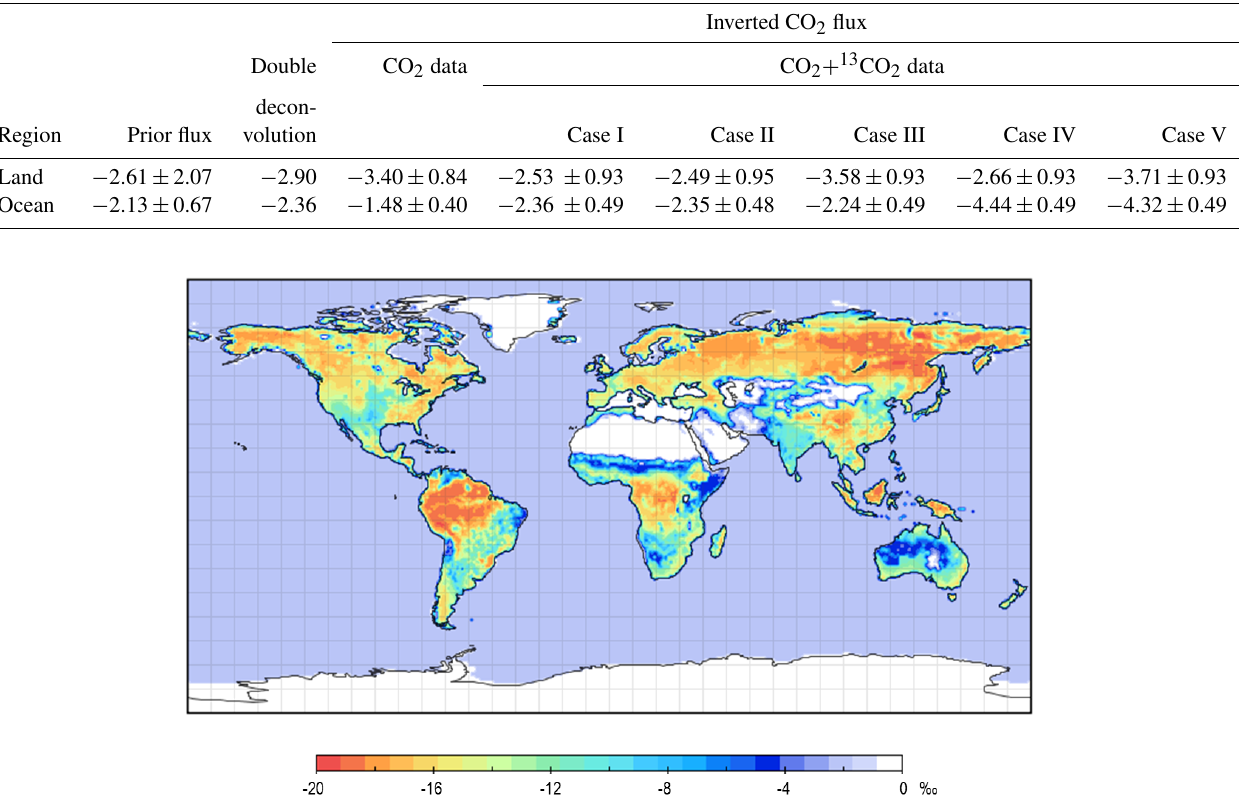
The global distribution of the total photosynthetic discrim- ination ( δ 13 C pt = δ 13 C a − (cid:49) ) modelled by BEPS is